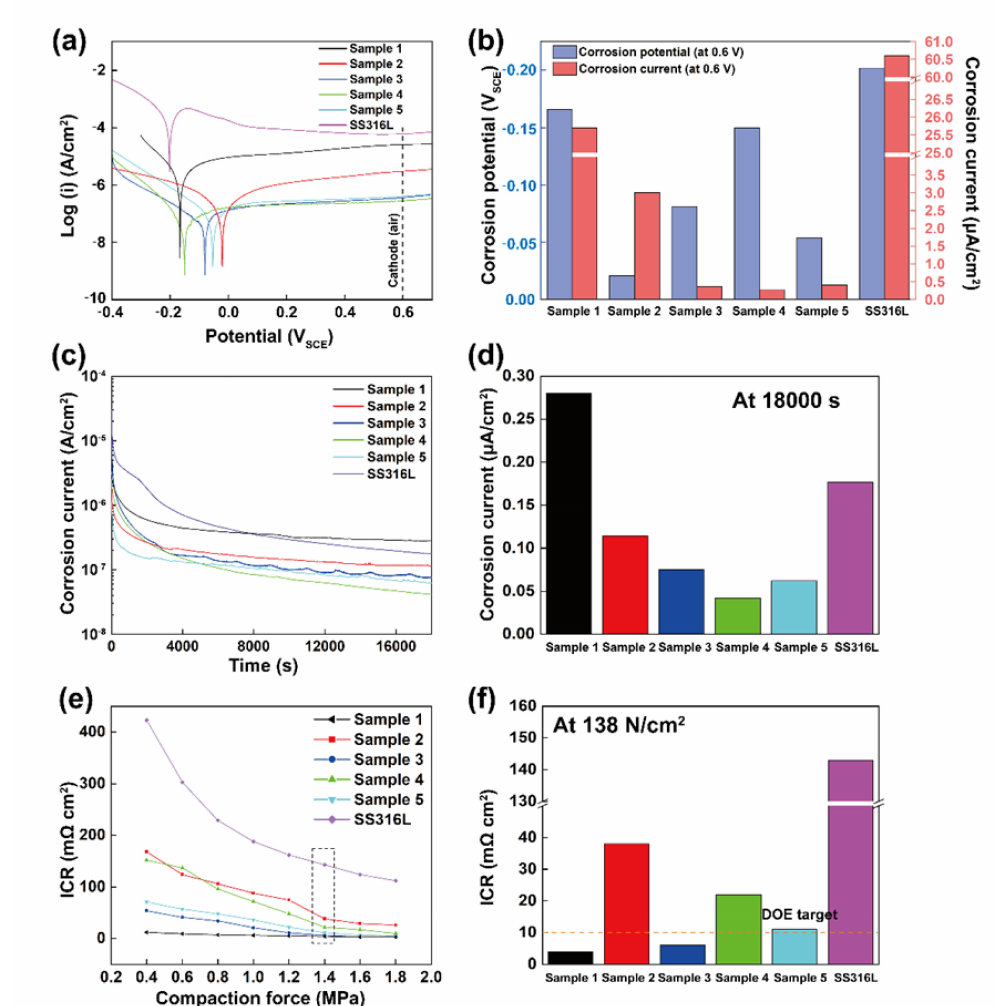
Figure 4. Electrochemical and electrical performance of coatings. ( a ) Potentiodynamic polarization curves of bare SS316L and coated samples in 0.5 M H 2 SO 4 + 2 ppm HF solution at 70 ◦ C. ( b ) Self- corrosion potential and corrosion current at 0.6 V measured by potentiodynamic polarization curves. ( c ) Potentiostatic polarization curves of uncoated SS316L and coated samples in 0.5 M H 2 SO 4 + 2 ppm HF solution at 70 ◦ C (at 0.6 V vs. SCE). ( d ) Current magnitude at 18,000 seconds after the potentiostatic program test (at 0.6 V vs. SCE). ( e ) Interface contact resistance test results after 5 h of potentiostatic polarization. ( f ) Contact resistance at the applied pressure of 138 N/cm 2